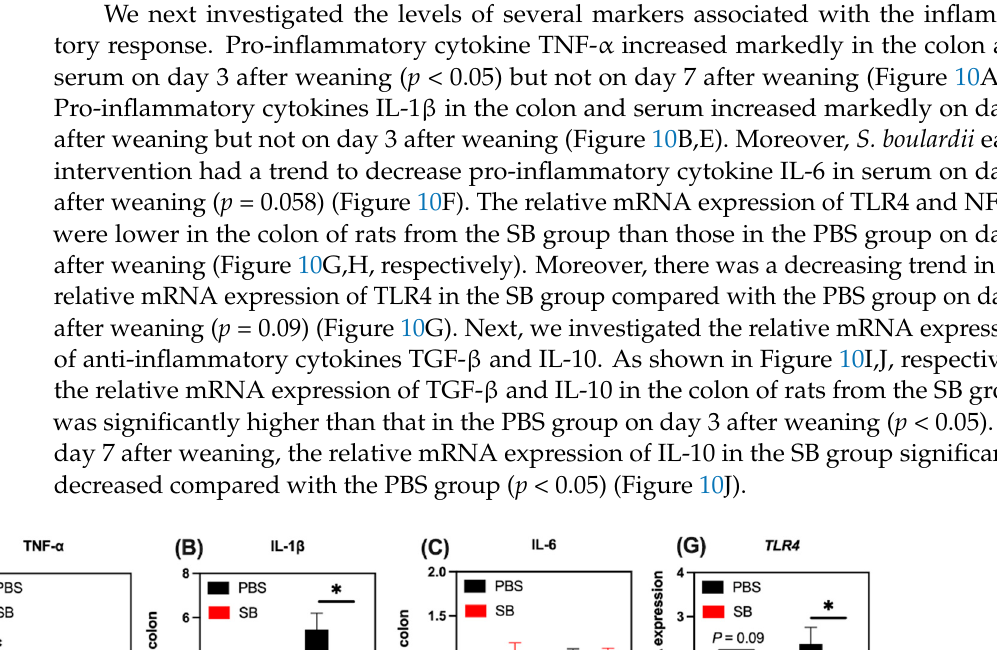
Figure 10. Effects of S. boulardii early intervention on the inflammatory response. The levels of TNF- α ( A ), IL-1 β ( B ), and IL-6 ( C ) in the colon. The levels of TNF- α ( D ), IL-1 β ( E ), and IL-6 ( F ) in serum. The relative mRNA expression of the gene for TLR4 ( G ), NF- κ B ( H ), TGF- β ( I ), and IL-10 ( J ). Values are expressed as means ± SEM, n = 10–12. * p < 0.05, ** p < 0.01. d, day. PBS, rats early intervened with phosphate buffer solution. SB, rats early intervened with S. boulardii . TNF- α , tumor necrosis factor α . IL-1 β , interleukin 1 β . IL-6, interleukin 6. TLR4, toll-like receptor 4. NF- κ B, nuclear factor kappa-light-chain-enhancer of activated B cells. TGF- β , transforming growth factor β . IL-10, inter- leukin 10. 4. Discussion Weaning, especially early weaning, exerts a negative impact on growth performance, development of gut mucosal barriers, and gut microbiome homeostasis for mammals [19]. Early life is a vital period for microbial colonization and the gut mucosal barrier matura- tion. Moreover, emerging research reported that microbial colonization contributes to gut mucosa development [19]. Thus, early microbial intervention is a good strategy to shape gut mucosal integrity and functions [20]. S. boulardii is a type of saccharomyces cerevisiae that exerts a beneficial effect on the growth performance and gut mucosal barrier and promotes gut microbiota development in sucking piglets [21,22]. Moreover, our previous study confirmed that early-life intervention using S. boulardii combined with fecal micro- biota transplantation can promote gut microbiota maturation, regulate the immune sys- tem, and alleviate weaning stress in piglets [23,24]. Thus, to emphasize the advantages of early microbial intervention for early weaning, we research the effect of S. boulardii early intervention after birth on the gut mucosal barrier functions and gut microbiome in early- weaned rats. The results had shown that S. boulardii early intervention improved the growth performance of weaned rats during day 3–7 and 1–7 after weaning.